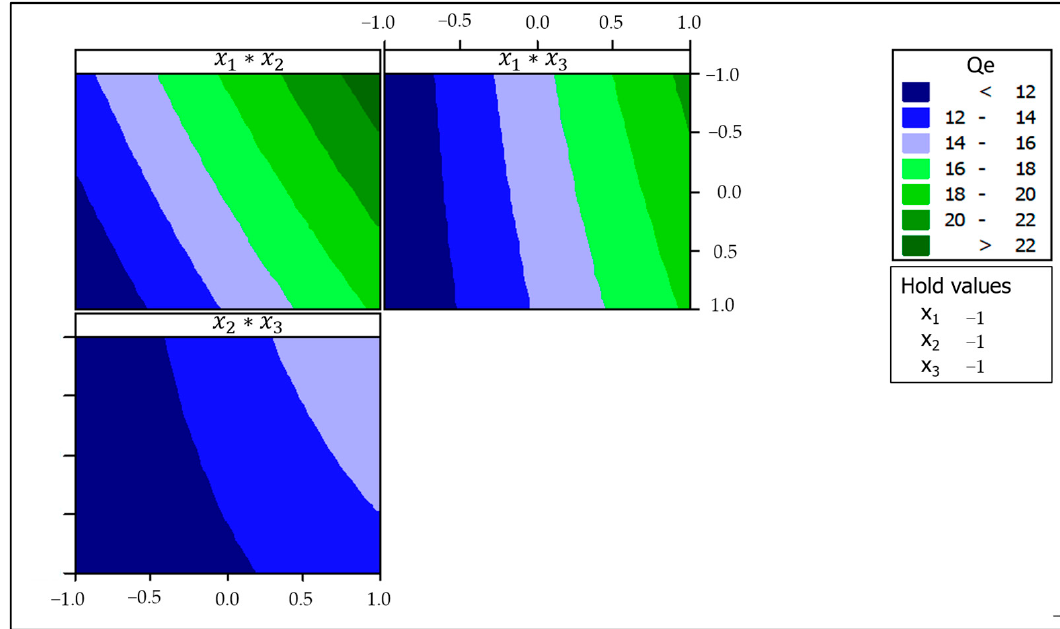
Figure 7. Contour plots for desorption of MB from the clay adsorbent coating. Figure 7 . Contour plots for desorption of MB from the clay adsorbent coating Figure 7 . Contour plots for desorption of MB from the clay adsorbent coating